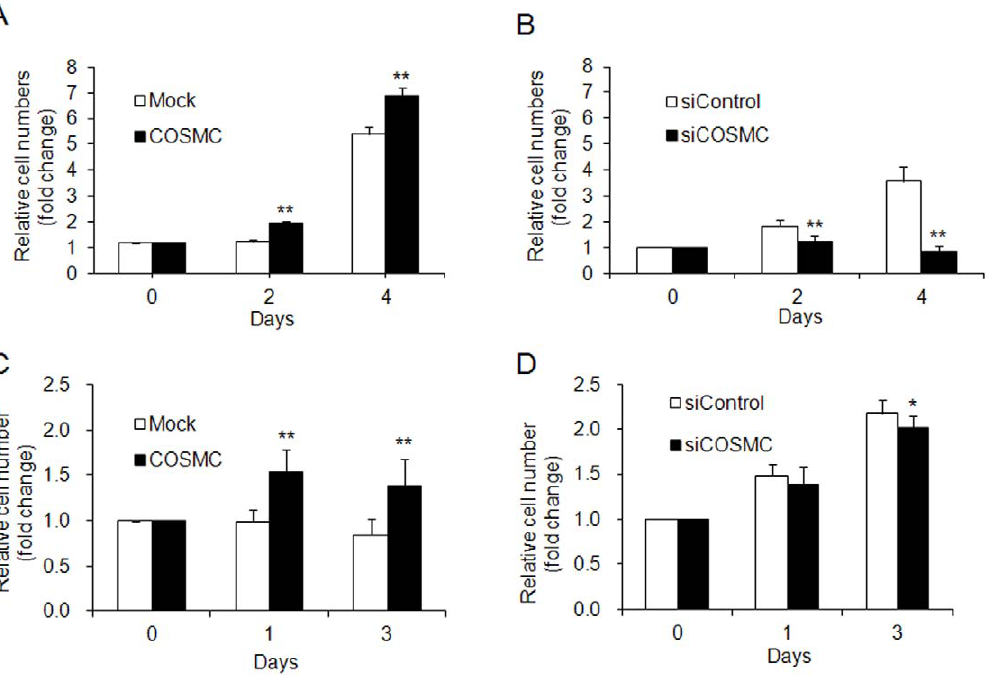
Figure 3. COSMC overexpression enhances cell growth in HUVECs. (A) Cell growth of HUVECs transfected with pcDNA3.1 control plasmid (open bars) or COSMC/pcDNA3.1 (closed bars) analyzed by trypan blue exclusion assays. (B) Cell growth of HUVECs transfected with control siRNA (open bars) or COSMC siRNA (closed bars) analyzed by trypan blue exclusion assays. (C) Cell growth of EA.hy926 cells overexpressing COSMC. (D) Cell growth of EA.hy926 cells with COSMC knockdown. Results are presented as means 6 SD from three independent experiments. * P , 0.05 and ** P , 0.01, compared with mock.